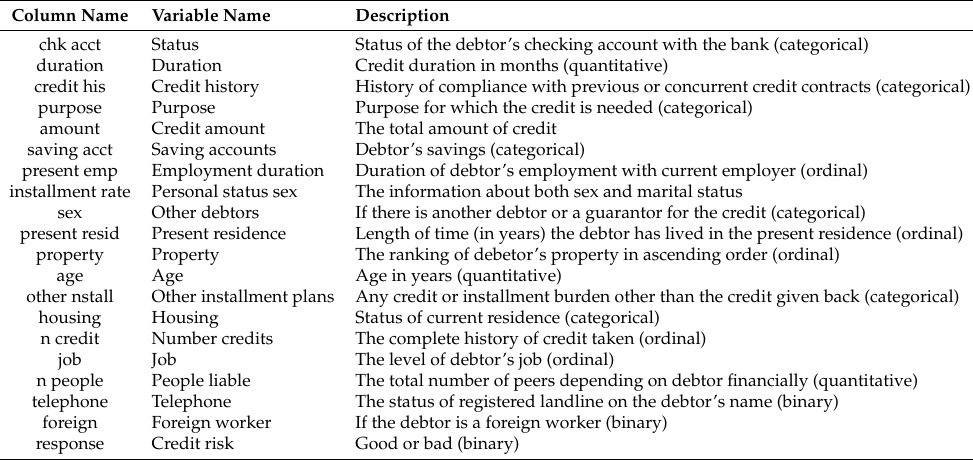
Table 2. Description of all the features in the German credit